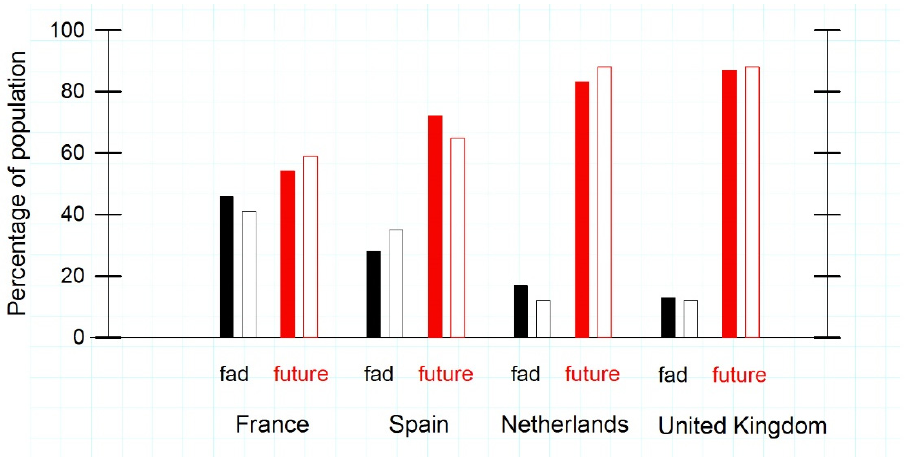
Figure 2. Does cultured meat have a future? Percentage of people’s (by gender) in each country in response to the question: “Do you think that dietary cultured muscle tissue derived protein provide realistic alternative to offset a growing demand for animal-based proteins?”. France, n = 484; Spain, n = 210; The Netherlands, n = 230; and the United Kingdom, n = 366. The solid black bars represent males who believe that cultured meat is a fad, white bars (black outline) represent females who believe that cultured meat is a fad, red bars represent males who believe that cultured meat has a future, and the white bars with red outlines represent females who believe that cultured meat has a future. Per gender, the two bars for each answer possibility (fad or future) together form 100% in each country. Chi-square tests were performed for each country, which revealed no significant association between gender and the opinion about the future of cultured meat. The data presented was normalised in order to compare the data to the same scale.